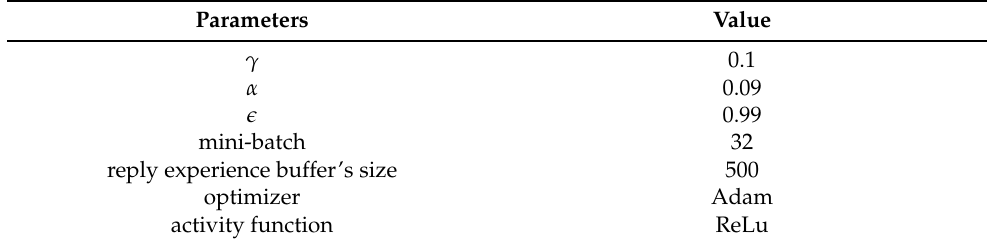
Table 4. The parameters of neural networks.